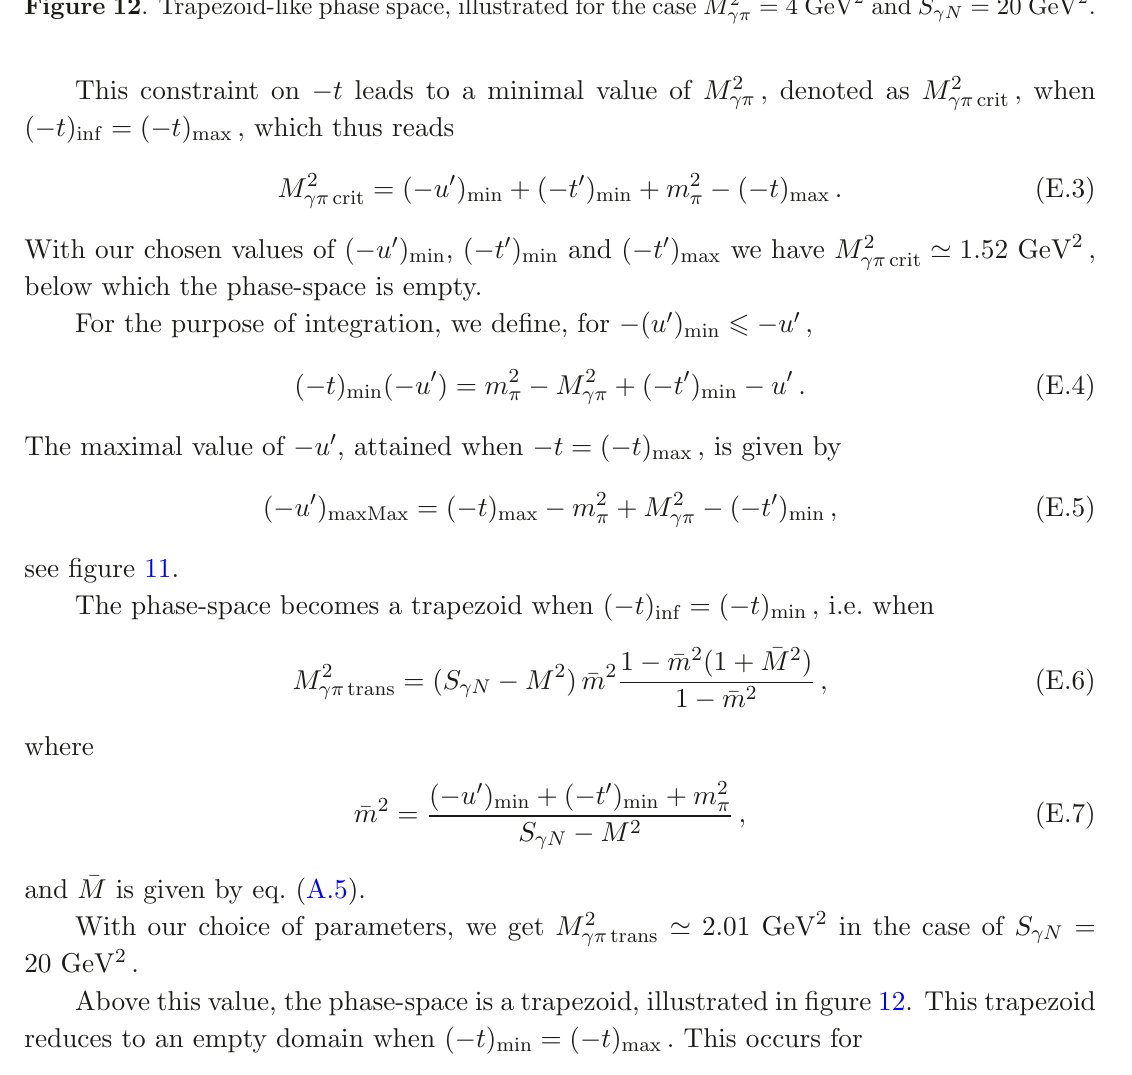
Figure 12 . Trapezoid-like phase space, illustrated for the case M 2